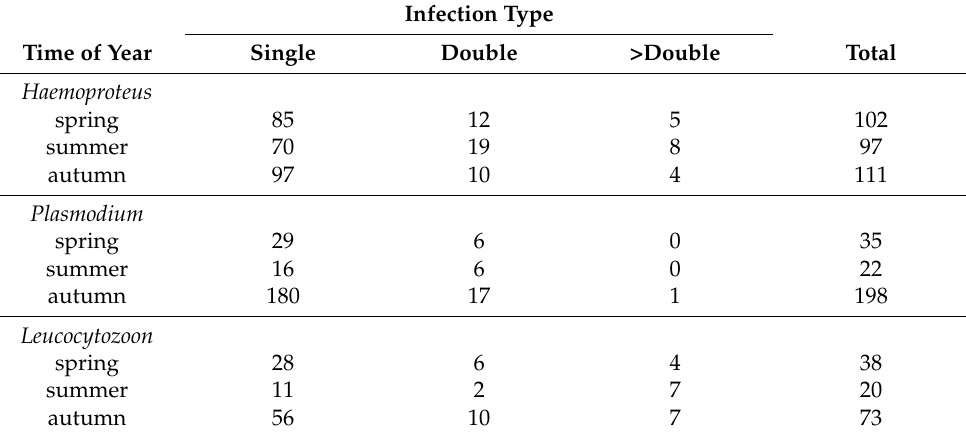
Table 3. Relationship between the type of intra-generic infection and time of year for the frequency of haemosporidian cytochrome b lineages detected in Drienovec, Slovakia, during 2017, 2018 and 2019. Note that haemosporidian lineage identity was not known for all parasites involved in multiple